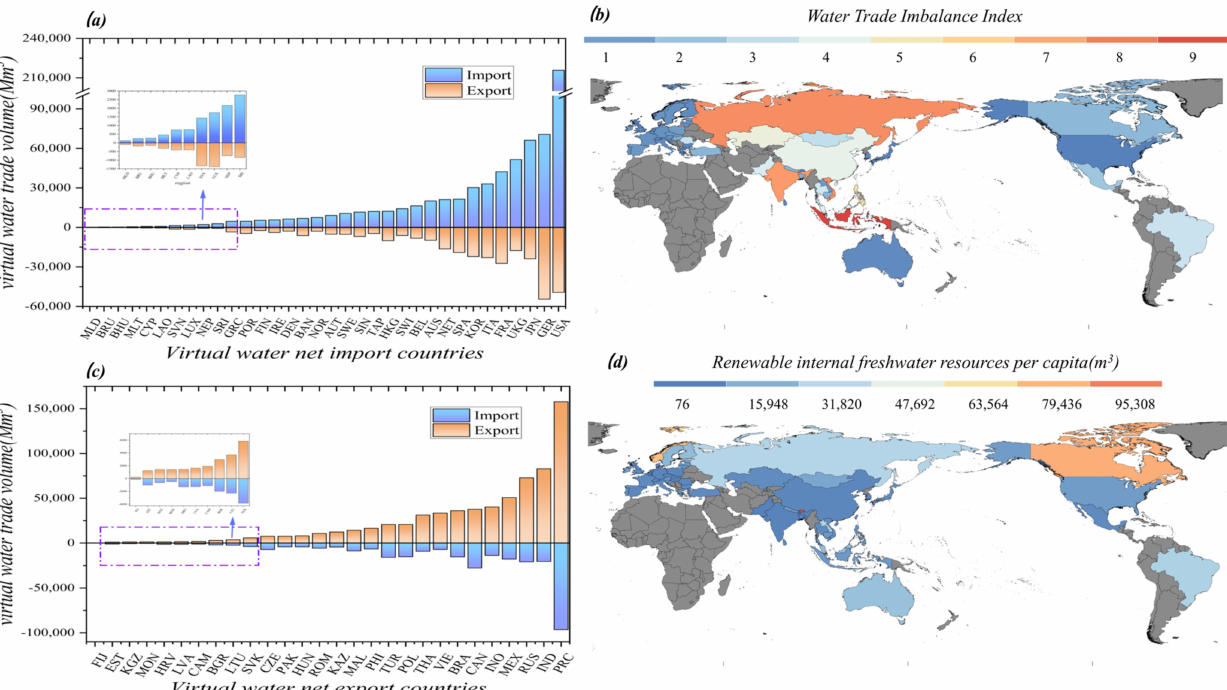
Figure 2. ( a ) Virtual water import and export volume of virtual water net importing countries/region; ( b ) virtual water import and export volume of virtual water net exporting countries; ( c ) WTI value of 62 countries/region (WTI value less than 1 is virtual water net importing country, if it is greater than 1, it is a virtual net exporter of water); ( d ) The per capita available fresh water in 62